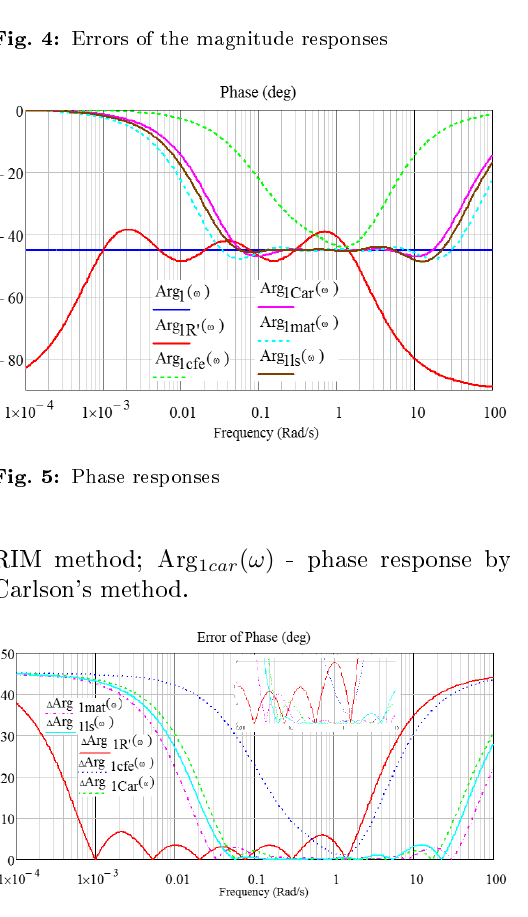
Fig. 6: Errors of the phase